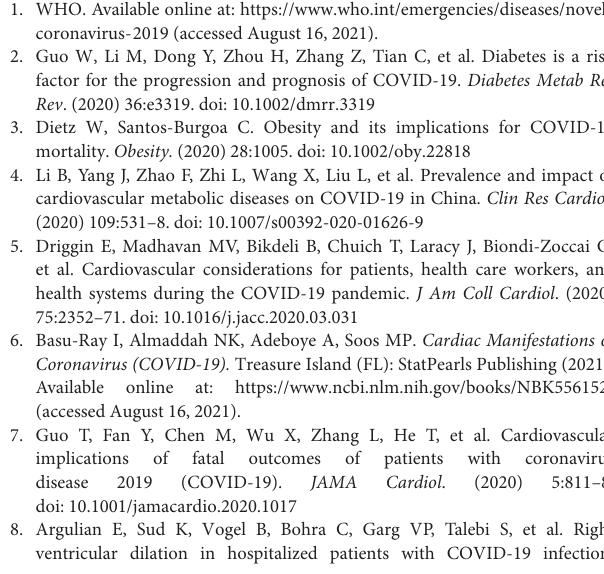
Supplementary Figure 1 | Flow chart of the experimental design. Supplementary Figure 2 | H&E sections (top panel) and Masson trichrome images (bottom panel) of right ventricles (RV) of coinfected male and female mice